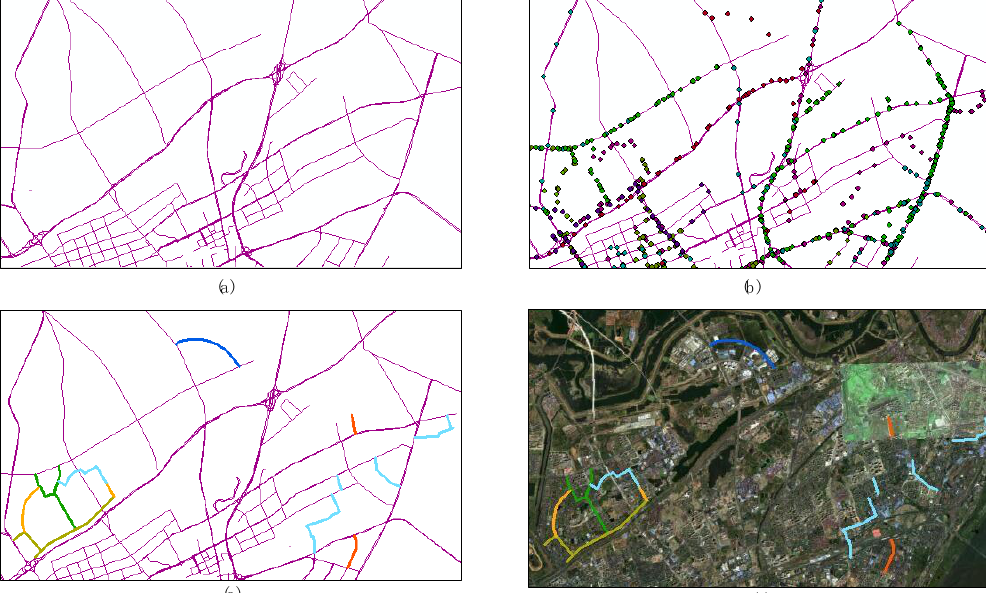
Figure 9. Six rounds of the road network updating experiment: ( a ) the original road network; ( b ) the input trajectories; ( c ) the updated road network; and ( d ) comparison between generated road segments and a satellite map.